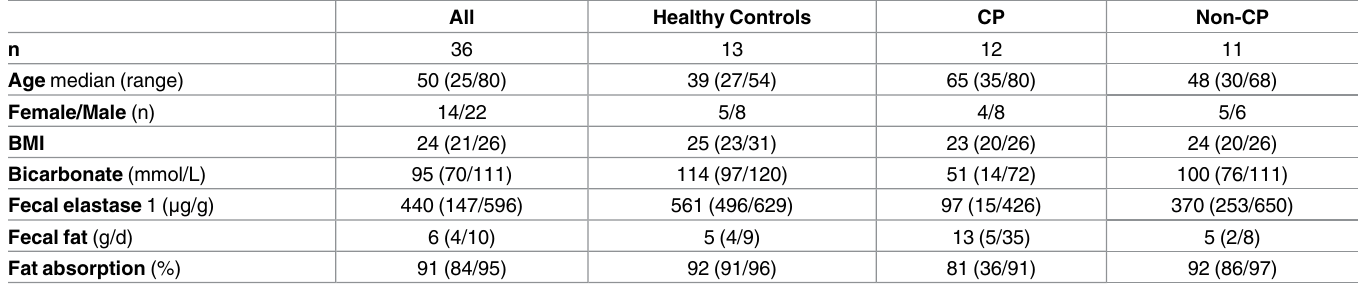
Table 1. Demographic data and results from pancreatic function testing.